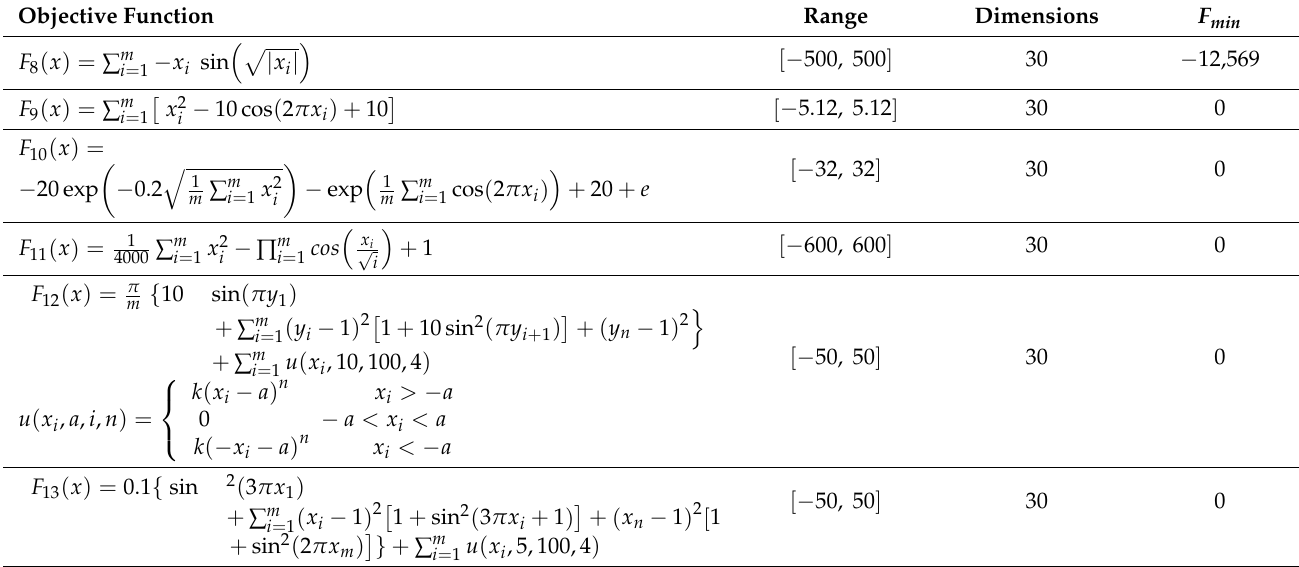
Table A2. Information of high-dimensional multimodal functions.